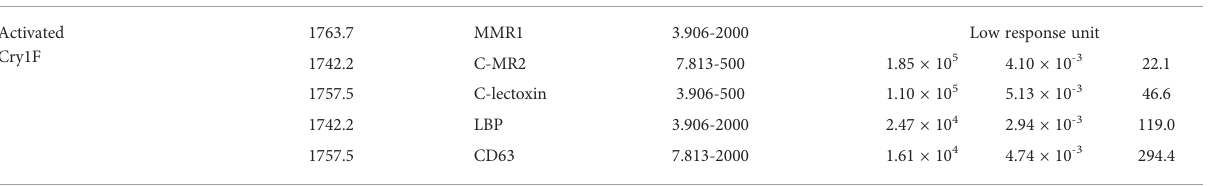
TABLE 3 SPR evaluation of Cry1F binding af fi nity with ACB C-type lectins and tetraspanin proteins.